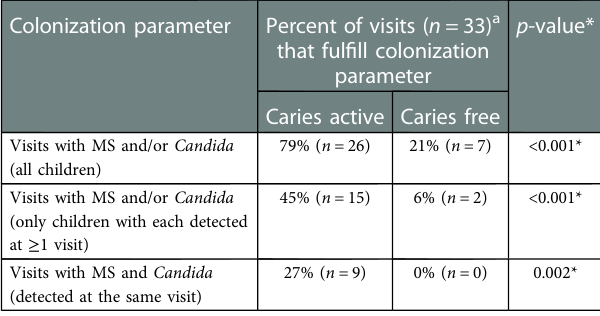
TABLE 2 Mean plaque microbial Index (PMI) per visit and mean overall plaque microbial Index (OPMI) and their association with caries status. Variable